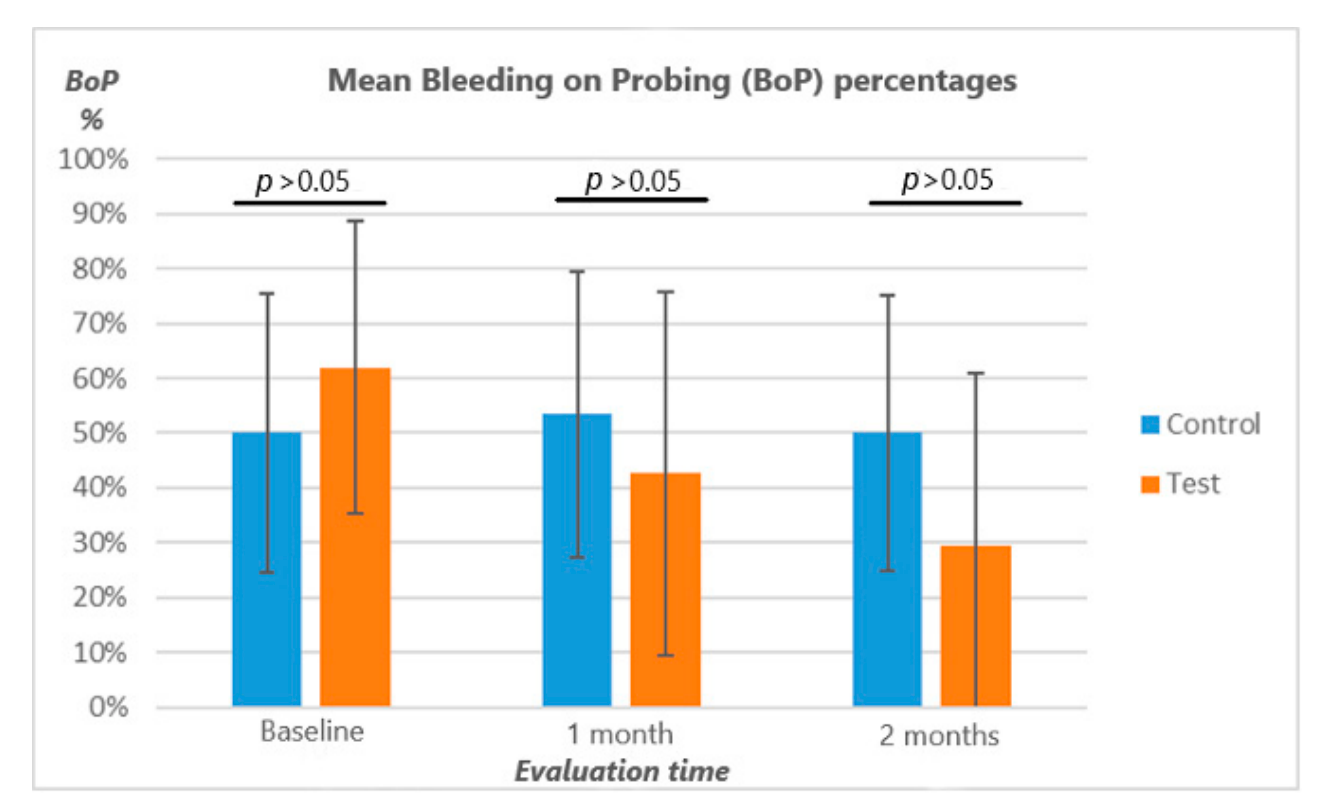
Table 5. Descriptive statistics of Bleeding Score measurements (BS).